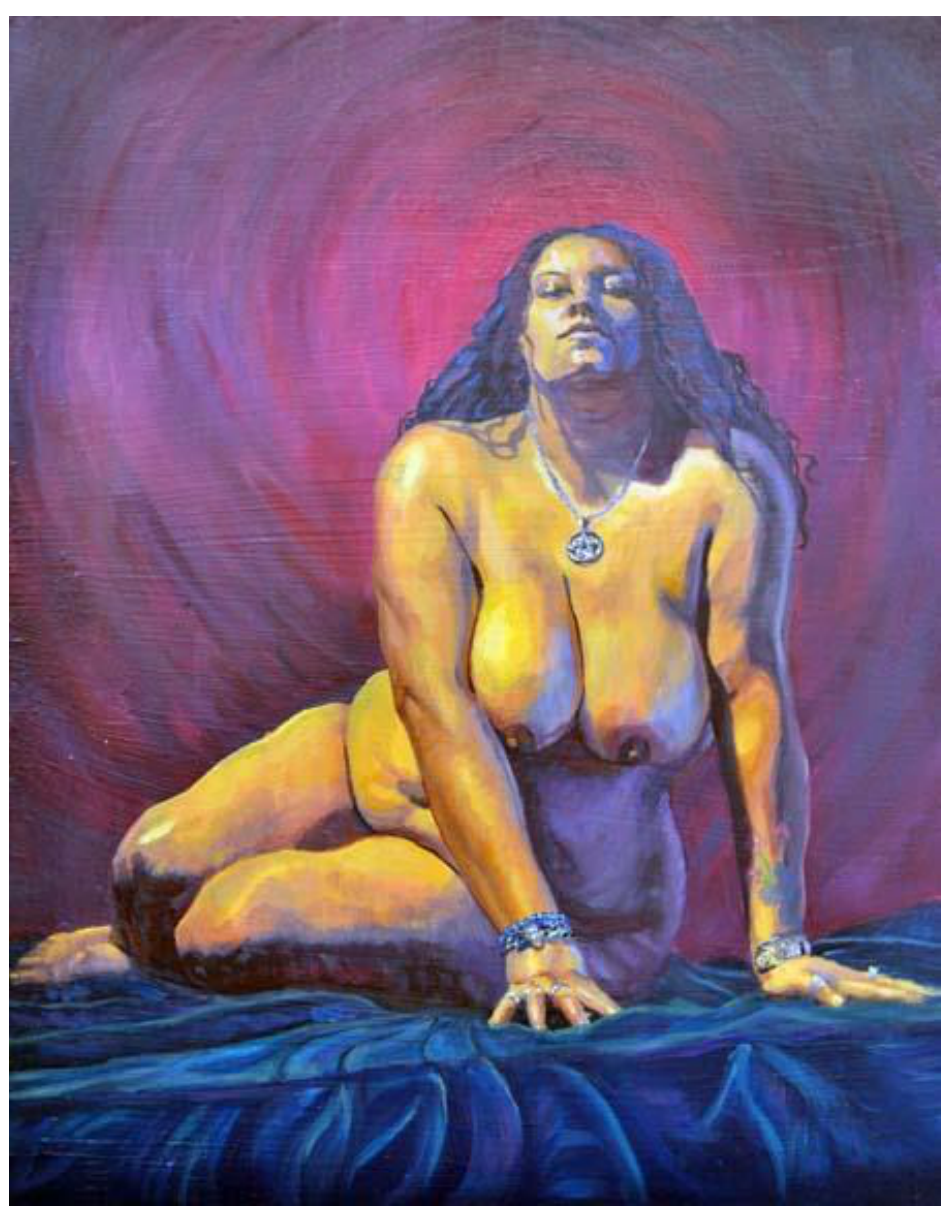
Figure 4 Cecelia Ivy Price, Coming to Confidence IV, 2014, Oil on